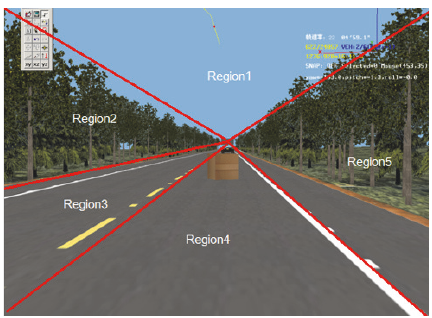
Figure 7: The fixation